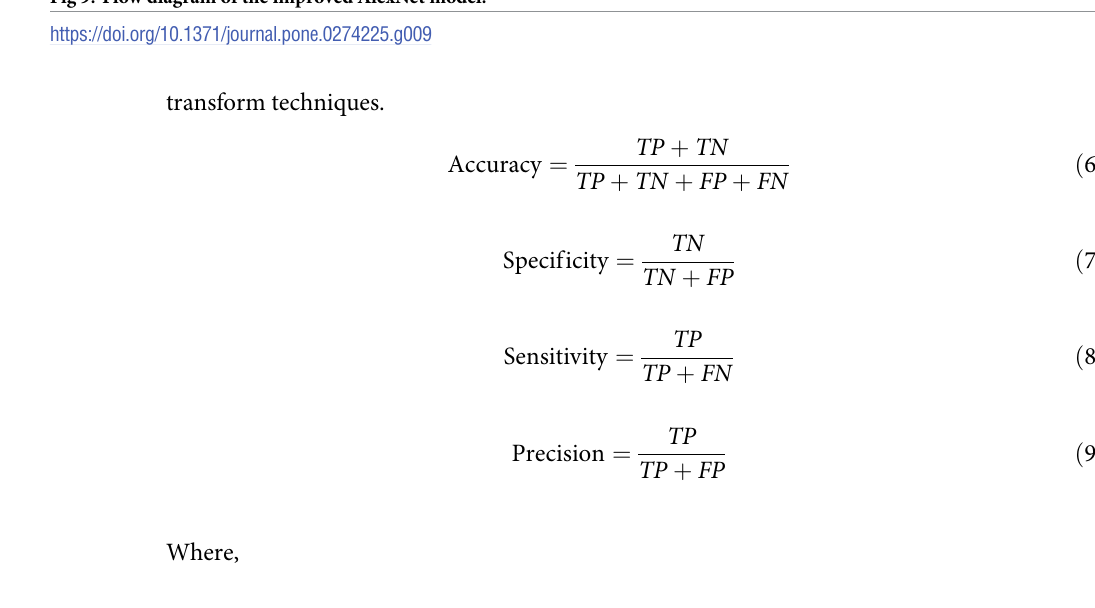
Fig 9. Flow diagram of the improved AlexNet